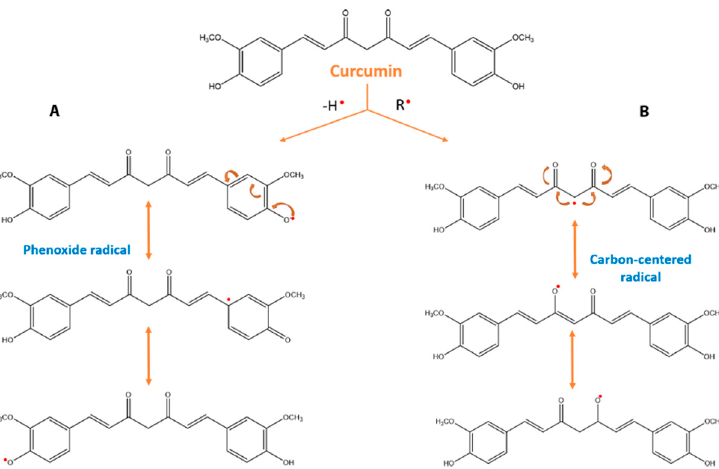
Figure 9. Antioxidant mechanism of curcumin. There are two mechanisms to form phenoxyl radicals. The first mechanism ( A ) begins by initial electron transfer to the free radical; thus, a radical cation is formed, which produces a phenoxyl radical by a proton loss. The second mechanism ( B ) is related to direct hydrogen abstraction. Based on the bond dissociation energies, many authors suggest that the most susceptible target for free radicals in curcumin is phenolic OH.